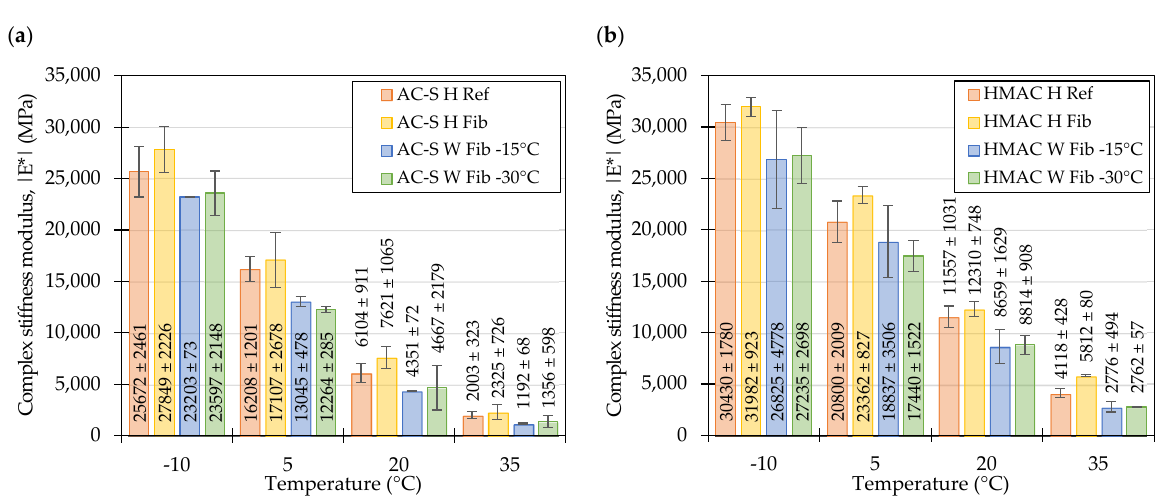
Figure 7. Complex stiffness moduli of laboratory produced mixtures measured at 10 Hz: Surface course mixtures ( a ), high modulus asphalt concrete mixtures ( b ), means and 95% confidence intervals (also shown as error bars). Table 5. Results of post-hoc Tukey HSD tests (p-values) for assessment of differences between the